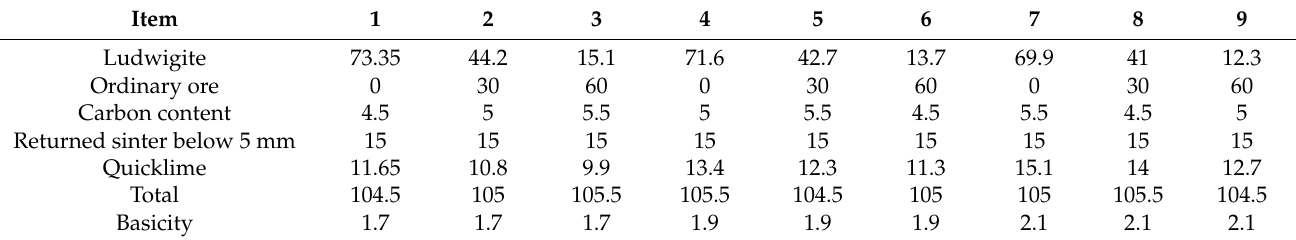
Table 5. Raw material adding scheme/wt%.